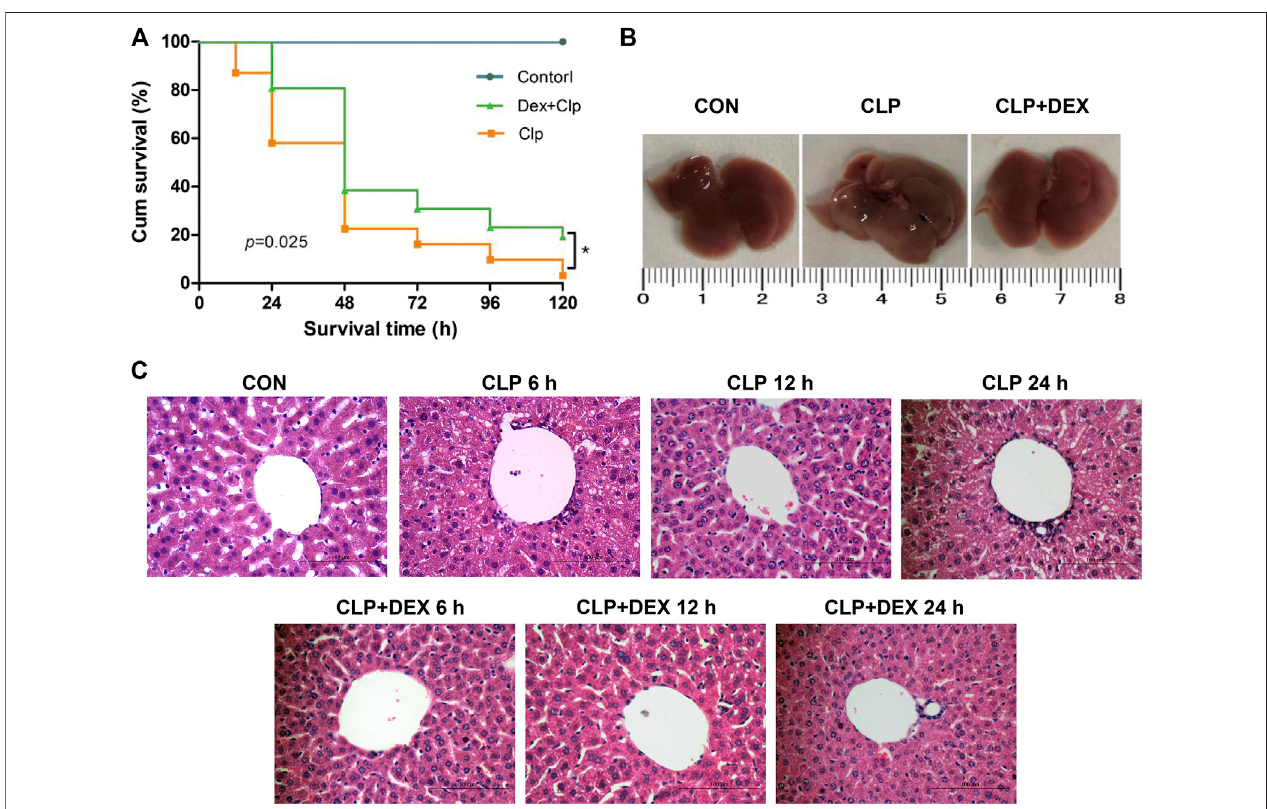
FIGURE1| Protective effect ofDEX inCLP-induced liverinjury. (A) Effect ofDEX onthe survival rateofsepticmice indifferentgroups. C57mice were subjected to CLP surgery, and survival ( n (cid:1) 31 for each CLP group, and n (cid:1) 8 for control group) was monitored for 120 h. (B) Image of entire liver taken from mice 24 h after CLP surgery in the CON, CLP, and CLP + DEX groups. (C) The role of DEX in pathological liver injury in septic mice in CON, CLP, and CLP + DEX group at 6, 12, and 24 h (Hematoxylin-and-Eosin stain; magni fi cation: × 400). * p < 0.05. CON: control; CLP: cecal ligation and puncture; DEX: